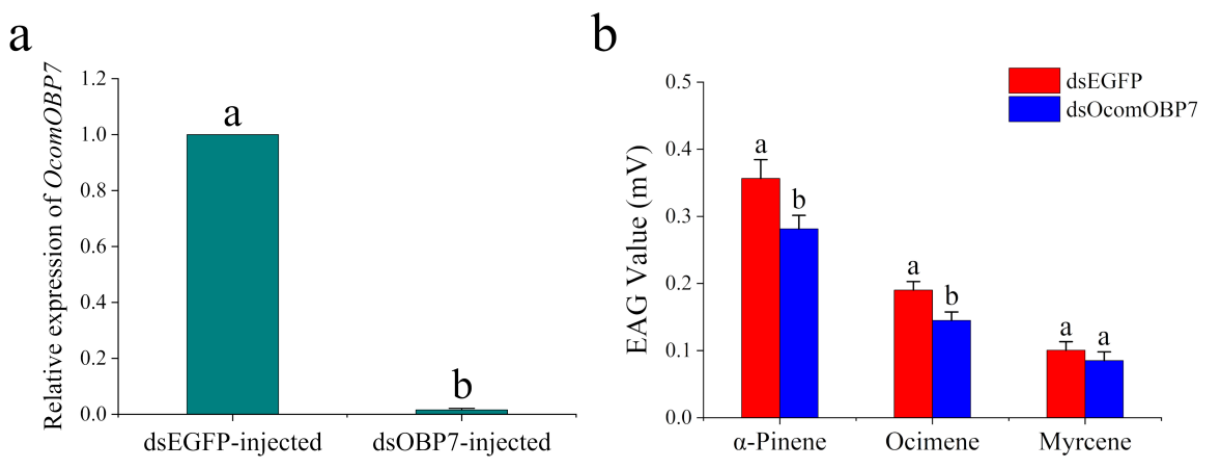
Figure 4. RNA interference of OcomOBP7 . ( a ) The relative expression level of OcomOBP7 after 48 h of RNAi. Different letters indicate significant differences at p < 0.05. ( b ) EAG response of O. communa to A. artemisiifolia volatiles 48 h after RNAi. The comparison between different treatment groups was analyzed using a nonparametric test. Different letters indicate significant differences at p < 0.05 using nonparametric test.